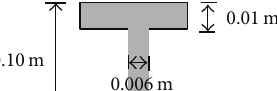
Example 1. A rectangular plate ( ℎ 𝑝 = 0.2 cm, 𝐸 𝑝 = 𝐸 𝑏 = 3 × 10 7 kN / m 2 , 𝜌